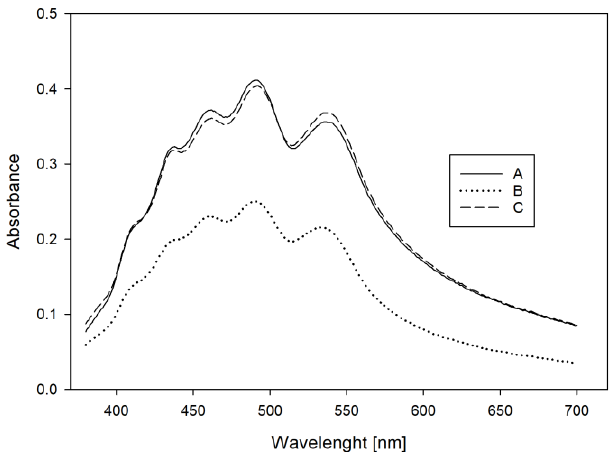
Figure 5. UV/Vis spectra of a spray dried carrot concentrate powder containing mixed tocopherols and sodium ascorbate as antioxidants (SD-Toc-SA-low) after production (A), after storage in air (B) and after storage in nitrogen flushed packaging (C) for 91 days at 35